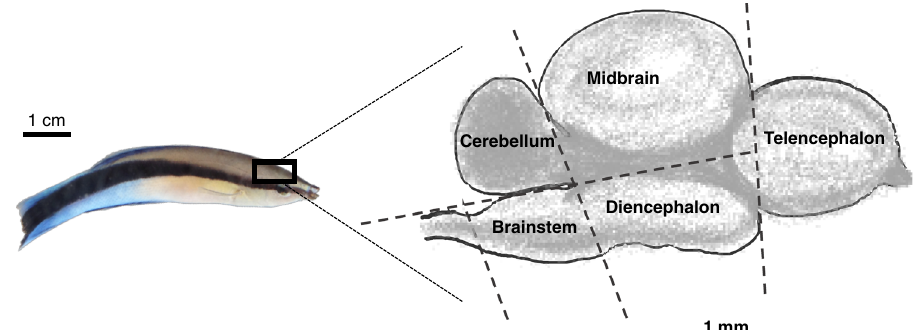
Fig. 1 A schematic representation of the cleaner fi sh ( Labroides dimidiatus ) brain. Cleaner fi sh brains were dissected into fi ve major brain parts. The telencephalon and diencephalon together form the forebrain. Photo and illustration by